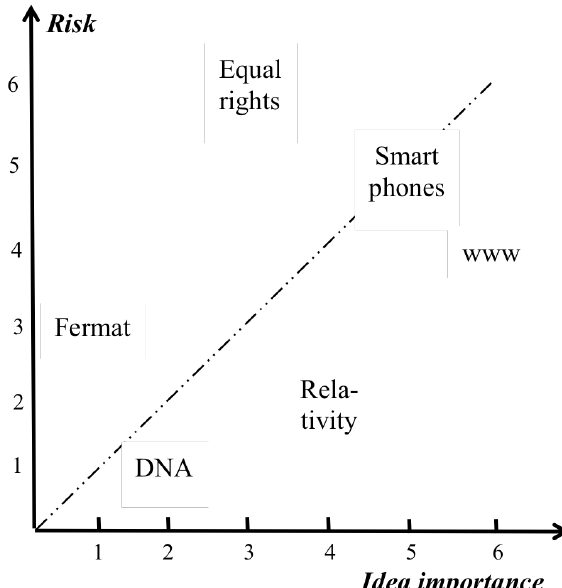
Fig. 3. The graph shows the overall risk ranking as a function of the idea importance ranking according to data of Table 1.